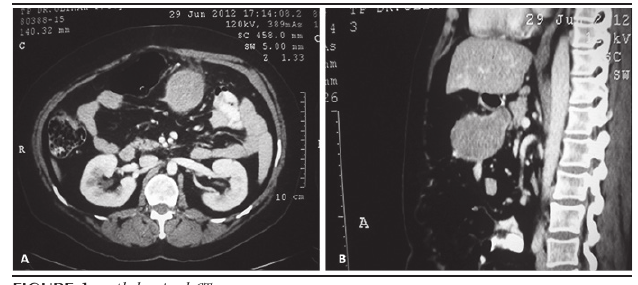
FDCS: follicular dendritic cell sarcoma.